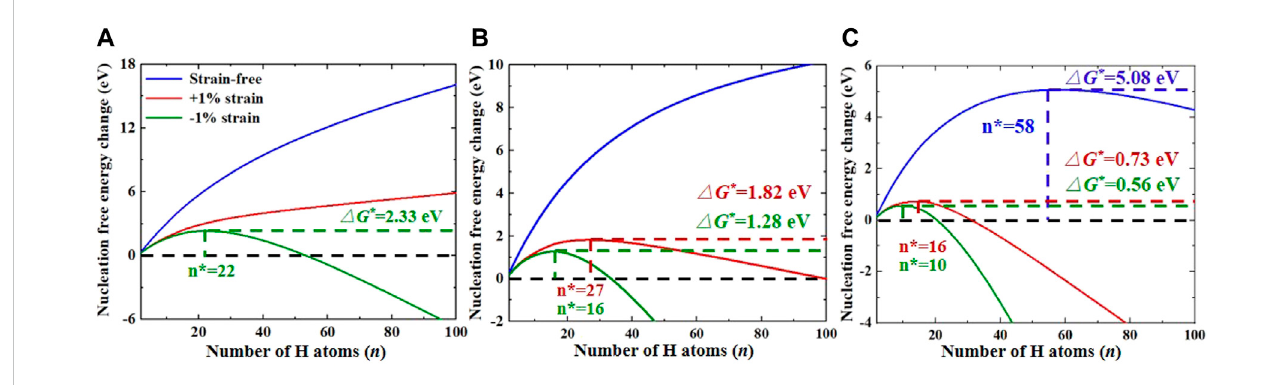
FIGURE 4 Nucleation free energy changes of planar H n clusters at 300 K with (A) 0.001 at.%, (B) 0.01 at.% and (C) 0.1 at.% H concentrations in strain-free and strained W ( − 1% or